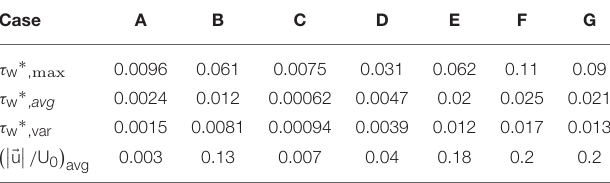
TABLE 2 | Normalized hemodynamic